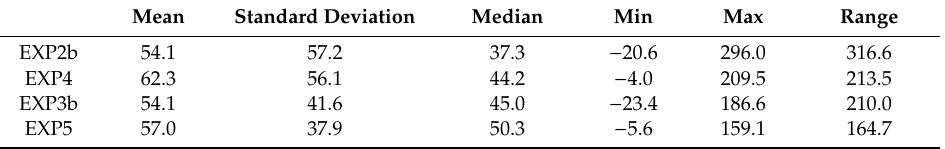
Table 20. LHF (W m − 2 ) simulated by UTOPIA and NOAH, initialized with GLDAS, at the FB station.